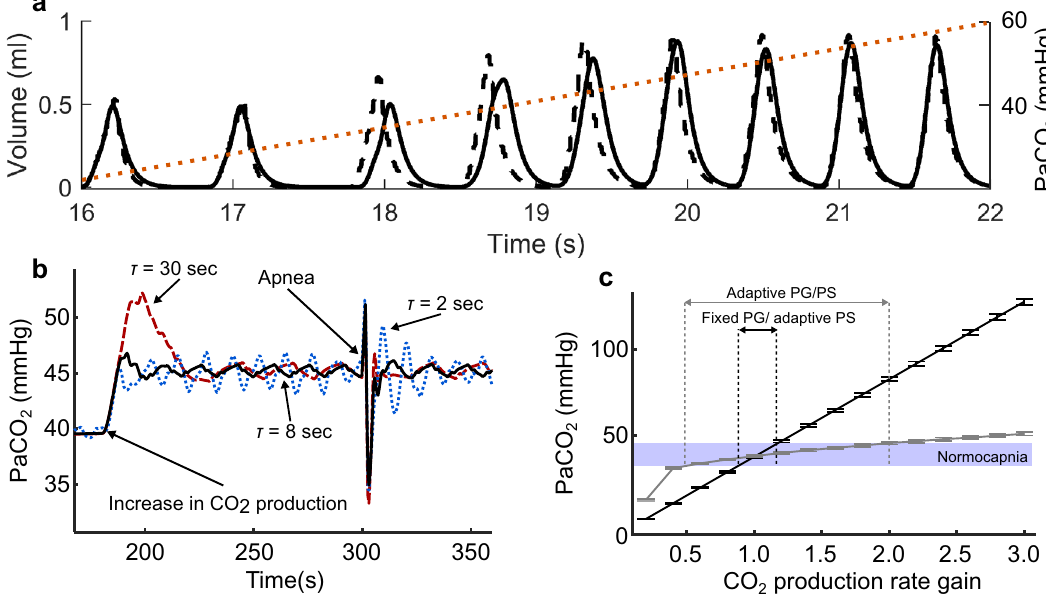
Figure 4. Adaptive PG/PS controller performance assessed in a computational testbed. ( a ) Adaptive PG, adaptive PS response to a ramping increase in PaCO 2 values. The PG module generates a prescribed ventilatory profile (dashed) in response to a controlled increase in PaCO 2 levels (dotted). The PS module responds by adapting stimulation to elicit a breath volume (solid) matching that of the pattern dictated by the PG. ( b ) Evaluation of the adaptive PG/PS response to PaCO 2 under chemo-transducer time constants of 2 s (dotted blue), 8 s (solid black), and 30 s (dashed red). A time constant of 8 s provided the best stability and robustness to perturbations. ( c ) Comparison between a fixed PG/adaptive PS (solid black) and an adaptive PG/PS controller’s (solid grey) ability to maintain normocapnia. The adaptive PG/PS can maintain normocapnia across a wider range of the baseline CO 2 production rate than the fixed PG/adaptive